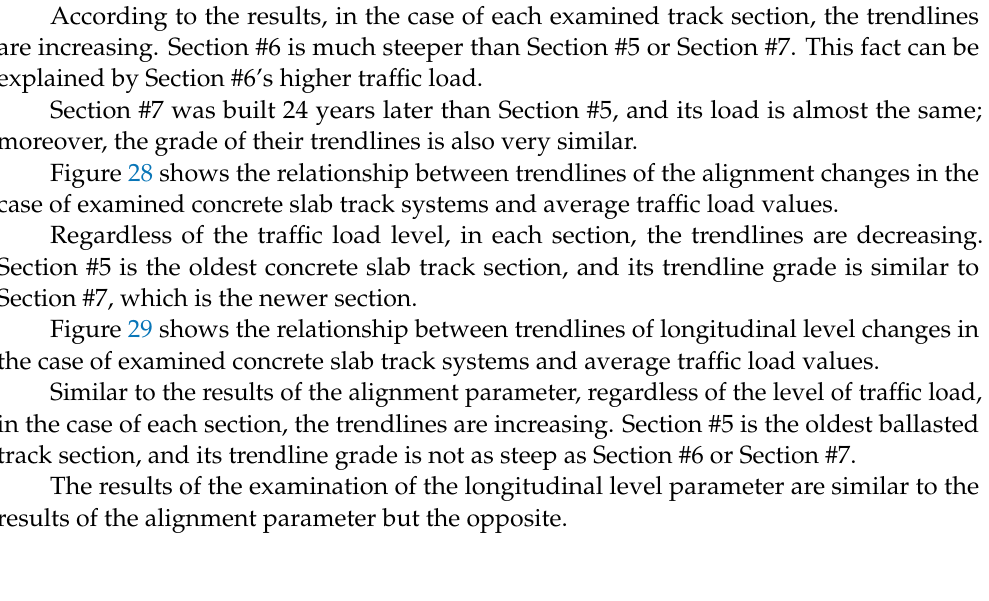
Figure 27. The relationship between track gauge and traffic load in concrete slab track